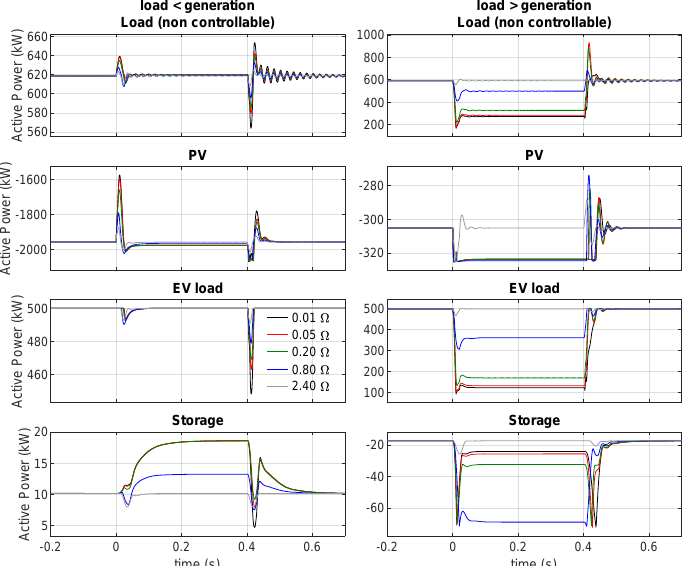
Figure 18. Active power per type of resources following balanced three-phase faults in the HV AC grid for the considered fault